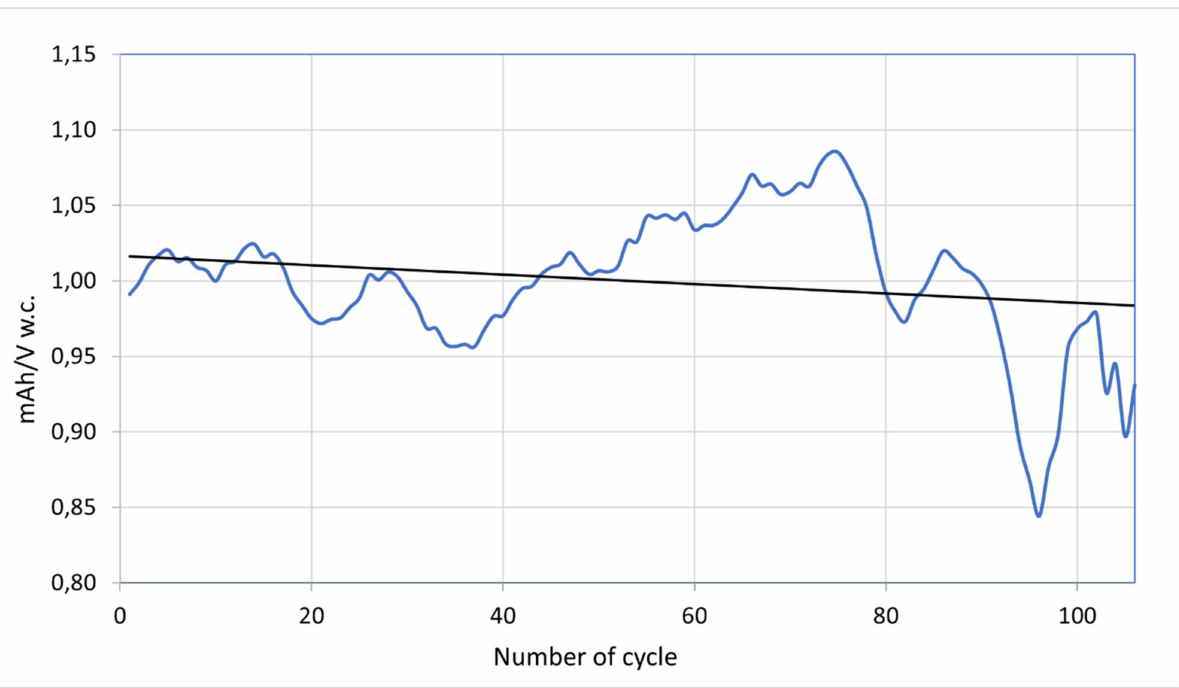
Figure 20. ∆ mAh/ ∆ V charged (w.c.) for battery